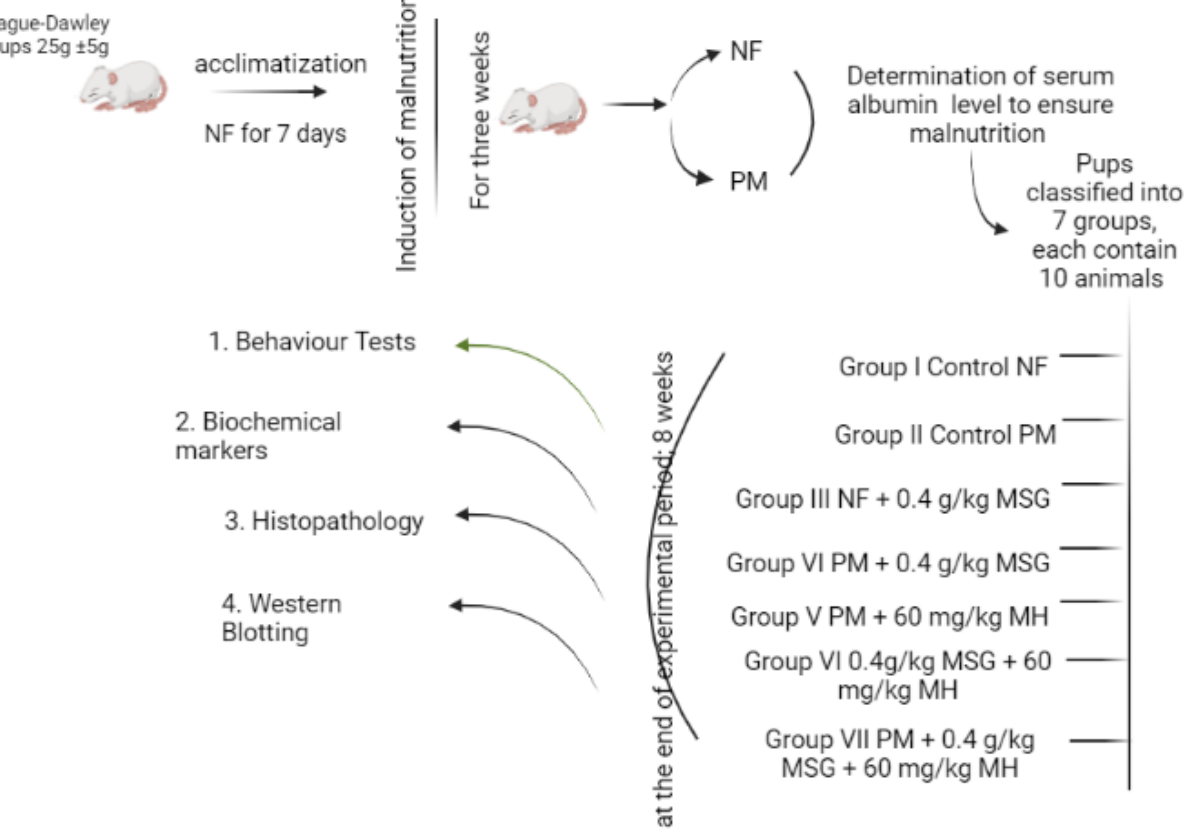
Figure 14. Investigating the protective mechanism of MH against MSG-induced malnutrition in NF and/PM rat pups.